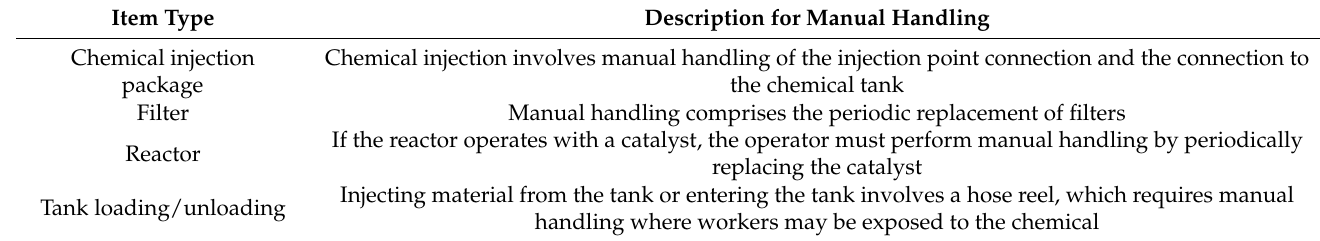
Table 4. Item list for manual